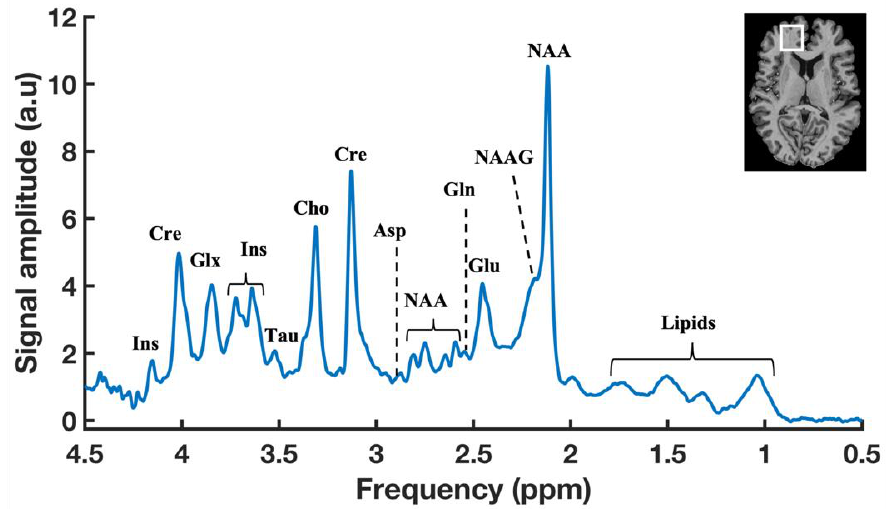
Figure 2. A typical 1 H-MR brain spectrum obtained by SVS with a localization scheme of using Semi-Localized by Adiabatic SElective Refocusing (sLASER) sequence (repetition time (TR) = 7000 ms, echo time (TE) = 30 ms, signal averages = 60, voxel = 25 × 20 × 17 mm, and acquisition time = 7 min) in the prefrontal cortex (PFC) of a healthy volunteer at 7T. Anatomical MR image of human brain showing the representation of voxel position placed in the PFC region (Top right).